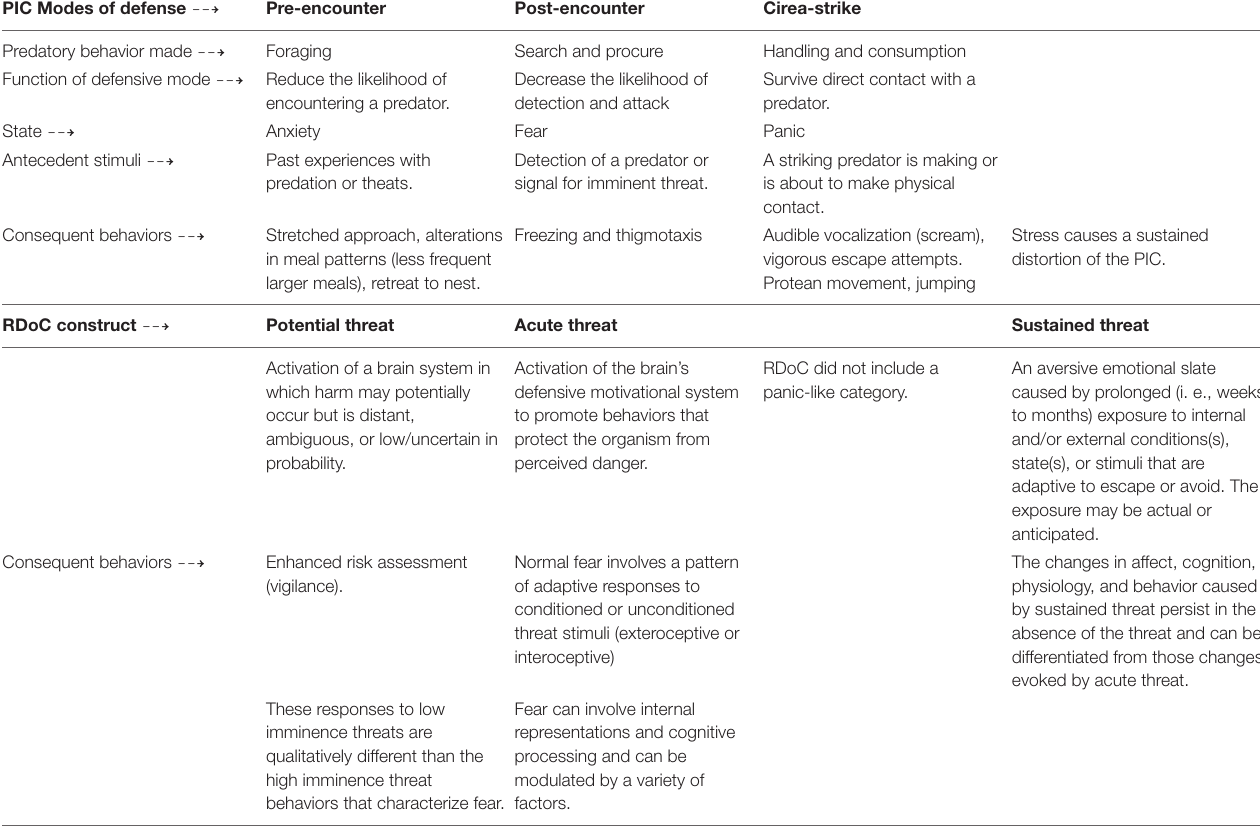
TABLE 1 | The organization of PIC defense modes and relevant RDoC constructs. PIC Modes of defense (cid:57)(cid:57)(cid:75) Pre-encounter Post-encounter Cirea-strike Foraging Search and